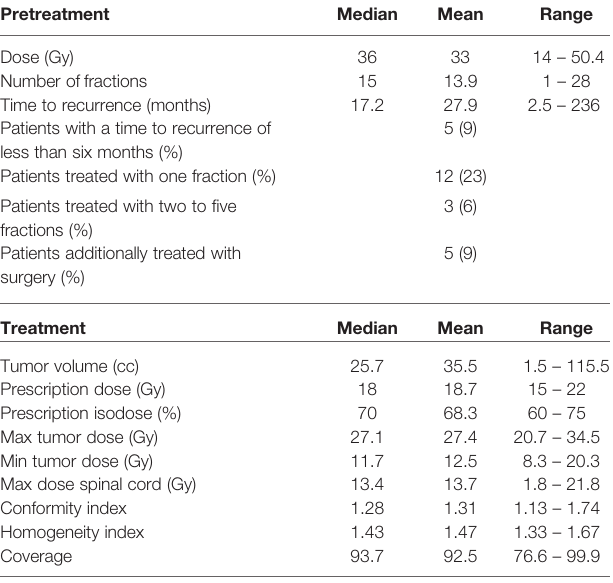
TABLE 2 | Pretreatment and treatment